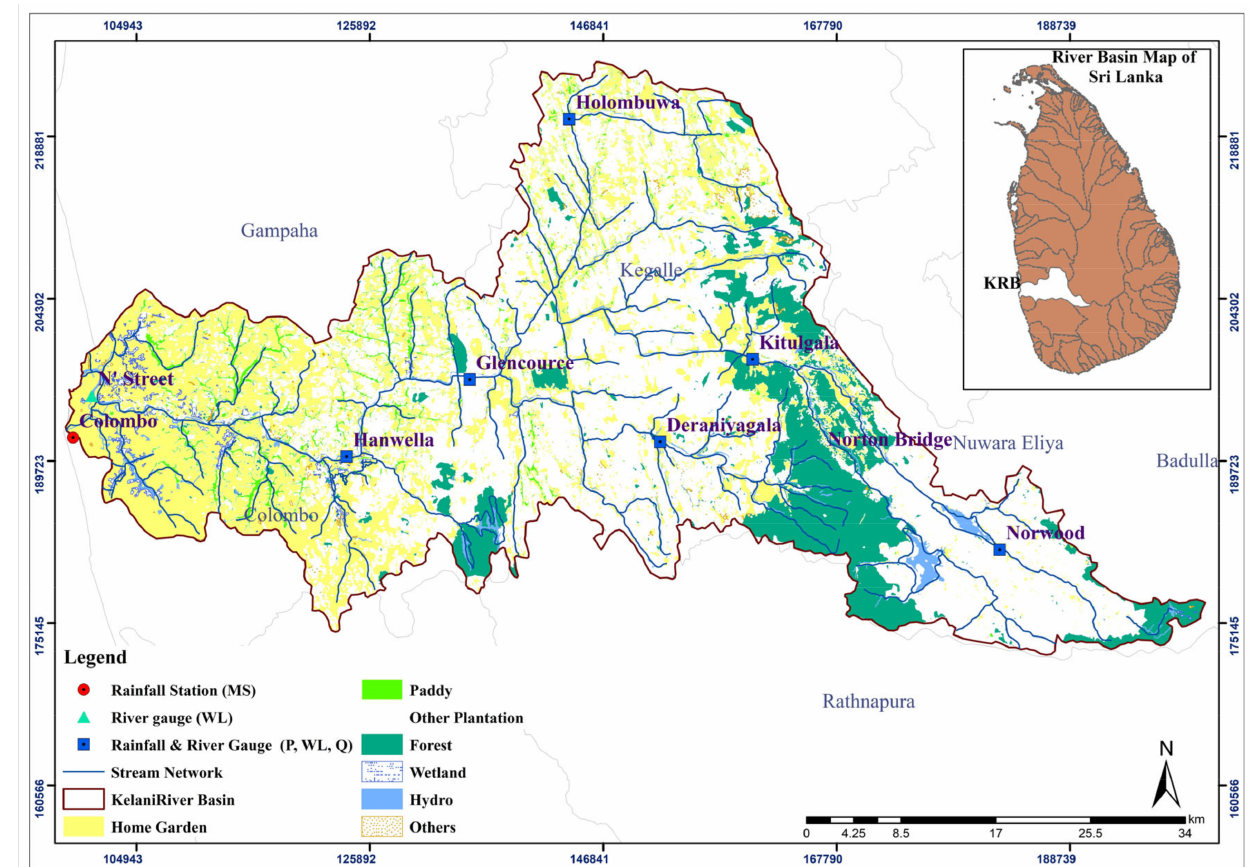
Figure 1. The map of the study